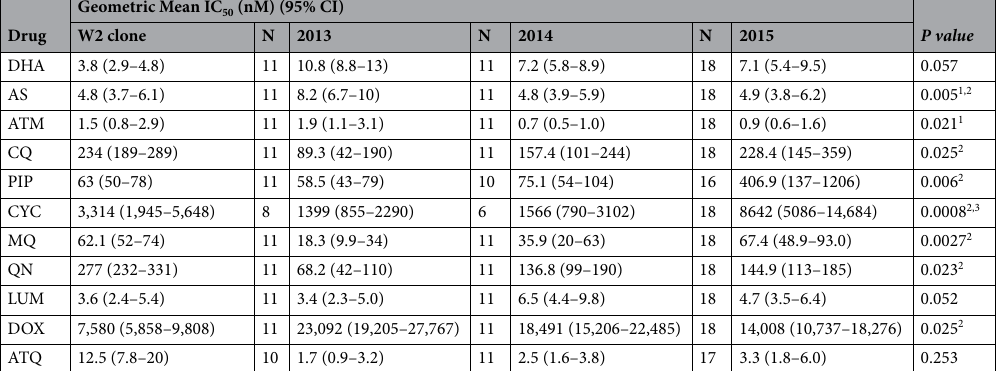
Table 3. In vitro susceptibility of P. falciparum isolates to dihydroartemisinin (DHA), artesunate (AS), artemisone (ATM), chloroquine (CQ), piperaquine (PIP), cycloguanil (CYC), mefloquine (MQ), quinine (QN), lumefantrine (LUM), doxycycline (DOX), atovaquone (ATQ). P values calculated by the Kruskal–Wallis test. 1, 2, 3 Significant difference calculated by Dunn’s multiple comparisons test of data in 2013/2014, 2013/2015, and 2014/2015,